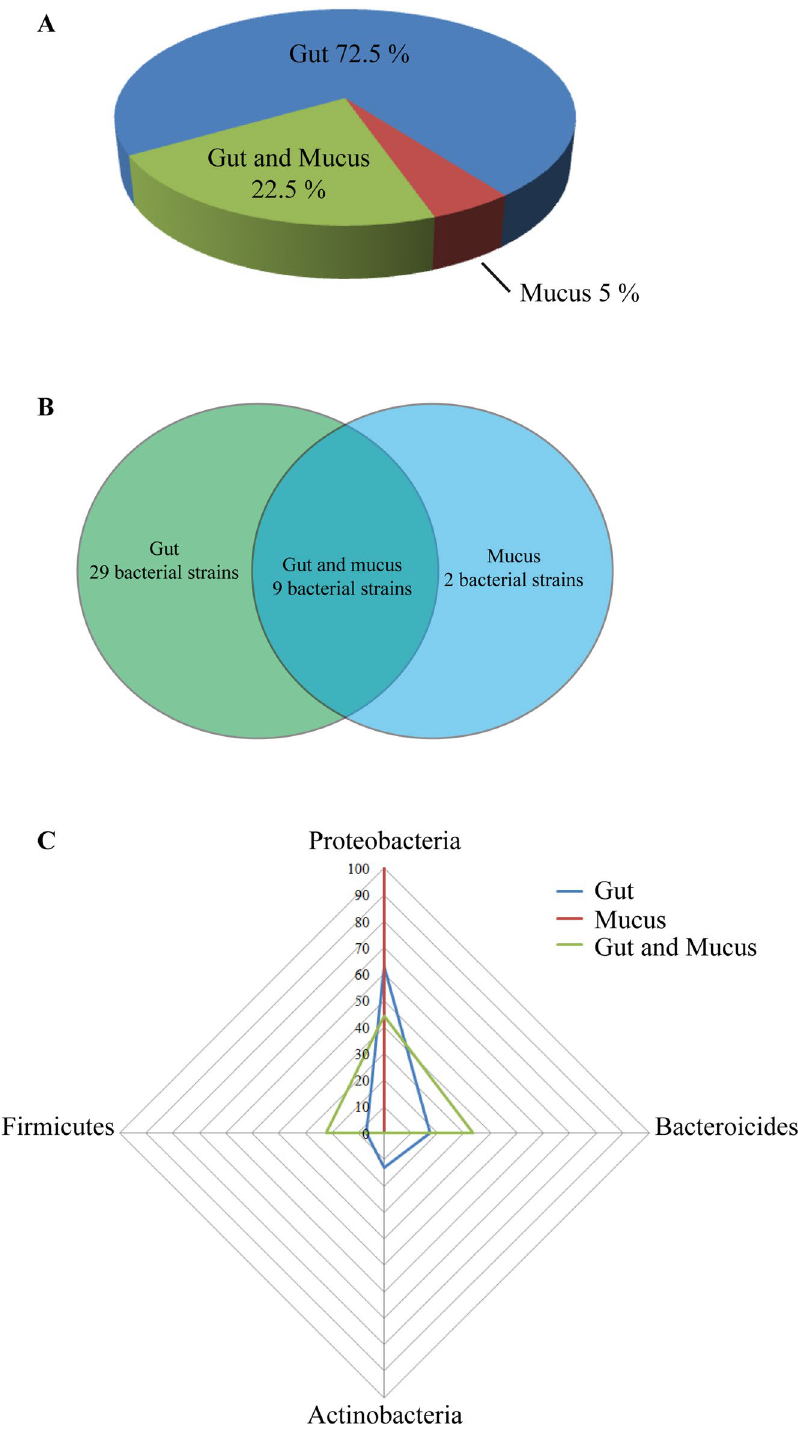
Figure 2. Bacterial distribution of the laboratory strain S. mediterranea starved for 2 weeks. ( A ) Distribution of the bacterial communities of the planarian S. mediterranea , ( B ) Venn diagram highlighting the bacterial number present in the gut and mucus epidermal (noted here as mucus), and the gut and epidermal mucus combined of S. mediterranea , ( C ) representation of the distribution of the bacterial phyla in the gut, epidermal mucus (noted here as mucus), and the gut and epidermal mucus combined of S. mediterranea . Five experiments were each performed on ten individual worms (see also Table S3). Identical results were obtained for each experiment and each worm